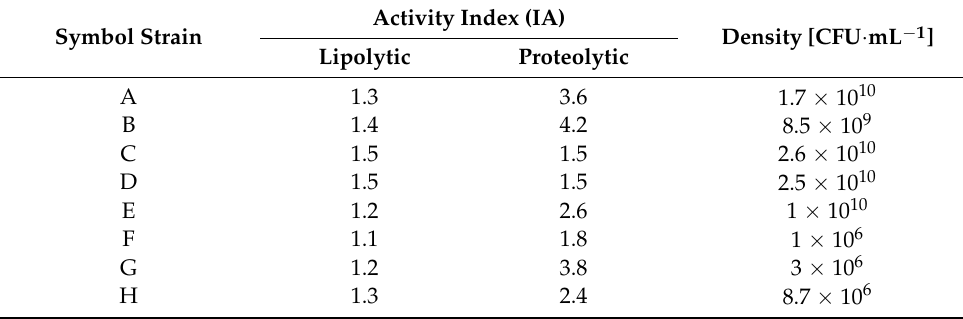
Table 1. Enzymatic activity and density of the bacterial strains